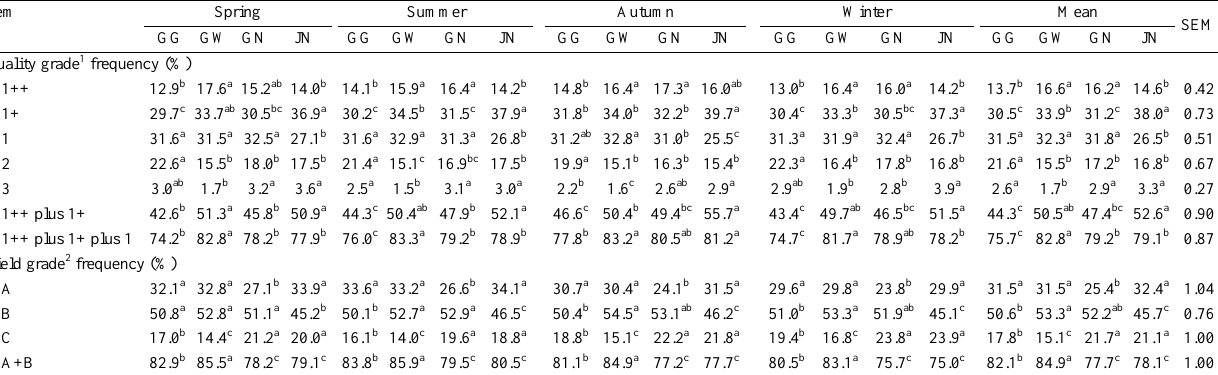
Table 7. Regional comparison of average quality frequency and yield frequency for 8 years (2006 through 2013) in Korean cattle steer carcasses